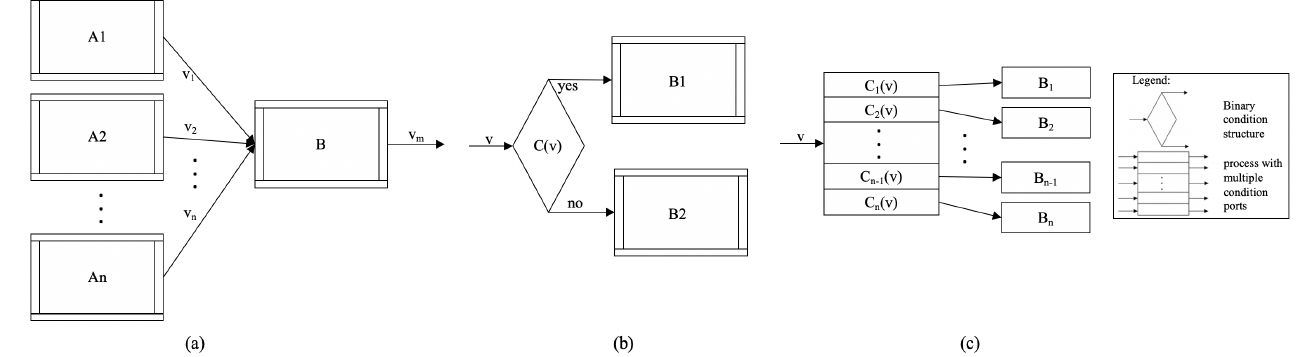
Figure 7. Different path connection